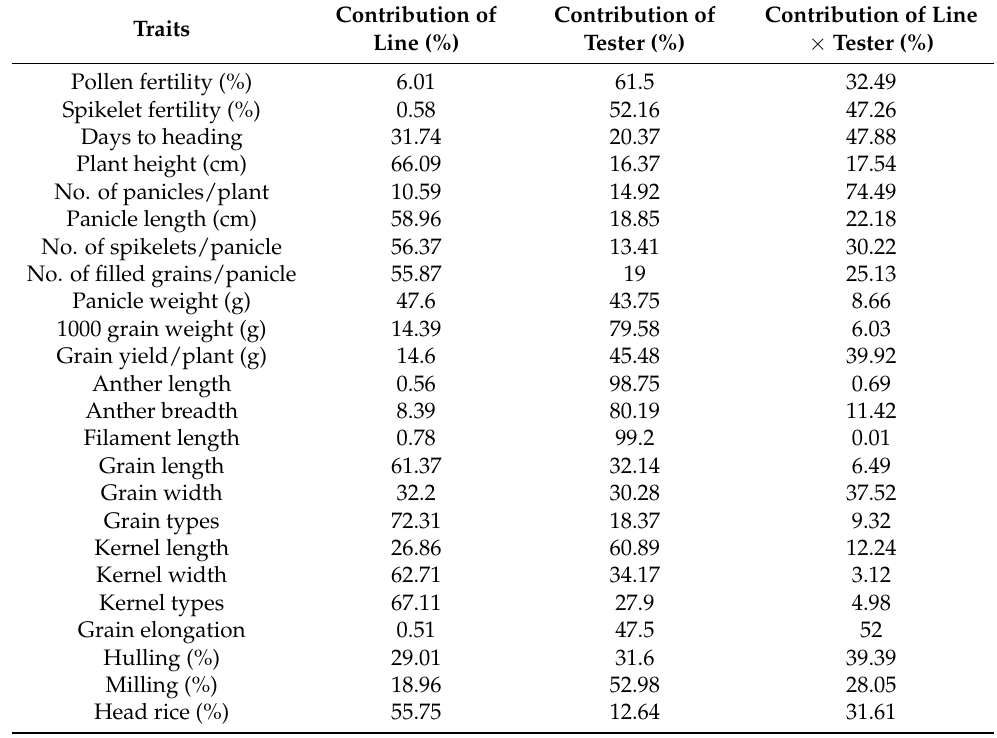
Table 7. Percent contribution of different components (lines, testers, and lines × testers) towards the crosses’ sum of squares for various traits in